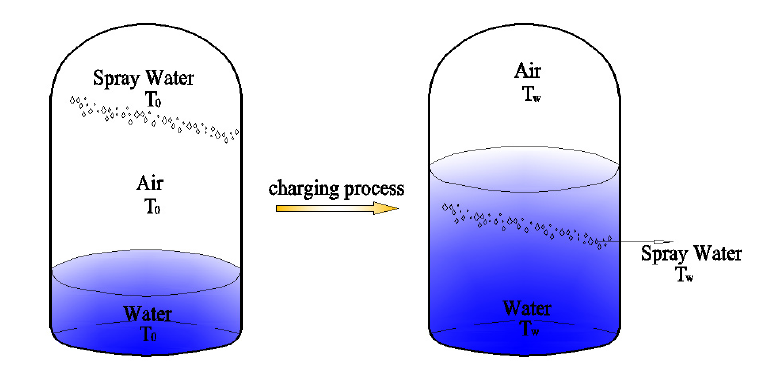
Figure 3. Temperature in the charging